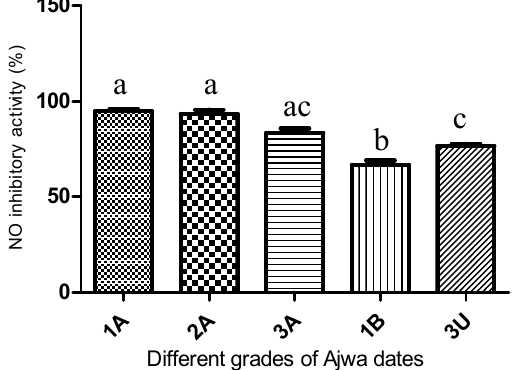
Figure 5. The percentage inhibition of NO inhibitory activity obtained from different grades of Ajwa with Samples 1A (Grade 1 from al-Aliah); 1B (Grade 1 from Bir Maashi); 3A (Grade 3 from al-Aliah) and 3U (Grade 3 from Uhud). The presented values are the mean of four replicates ± SD. Each different letter (a, b and c) above the column indicates that the results are statistically significant differences ( p < 0.05; n = 6) and the letter “ac” is not significant different from “a” and “c”.